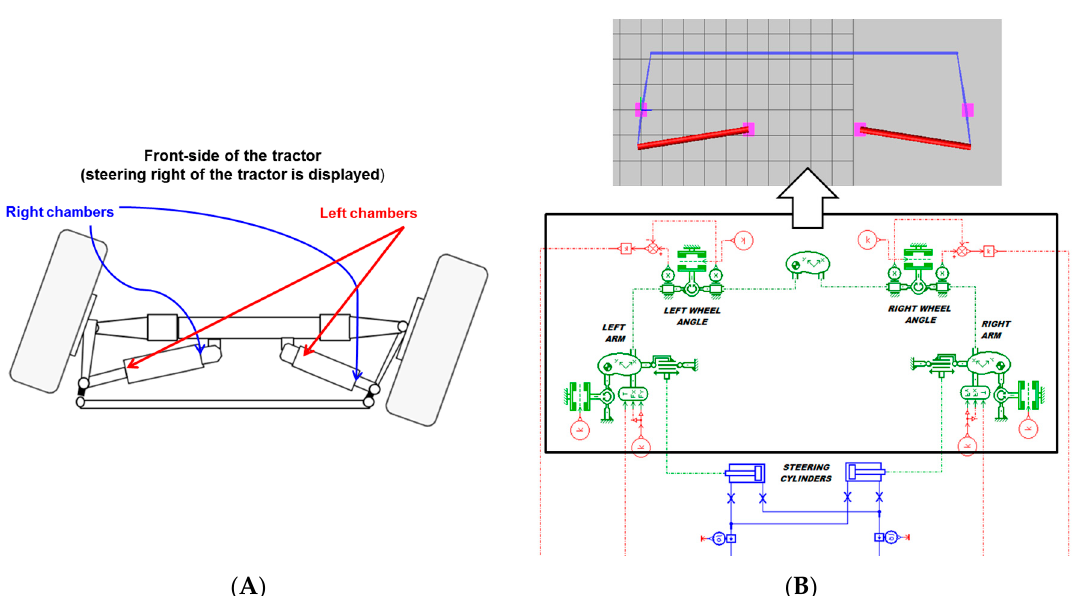
Figure 7. ( A ) Steering mechanism; ( B ) Model of the steering mechanism connected to the steering hydraulic cylinders.